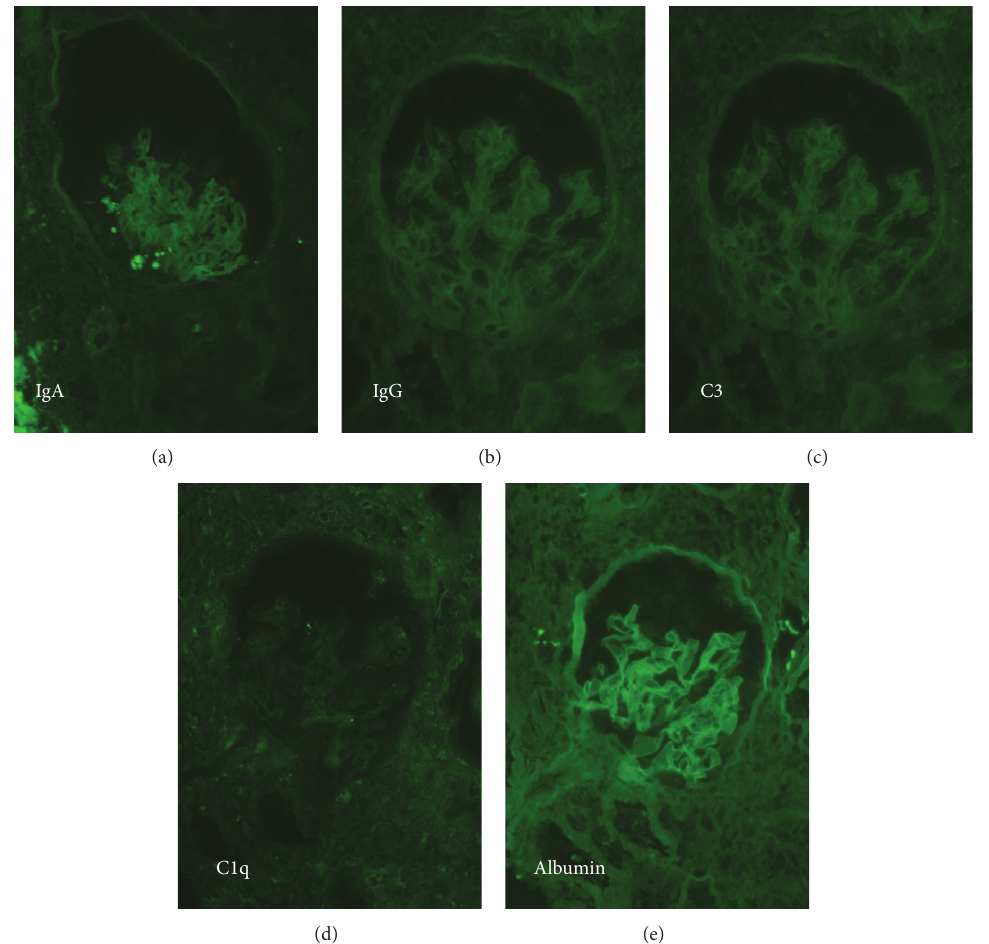
Figure 3: Immunofluorescence study negative for IgA, IgG, C3, and C1q (albumin